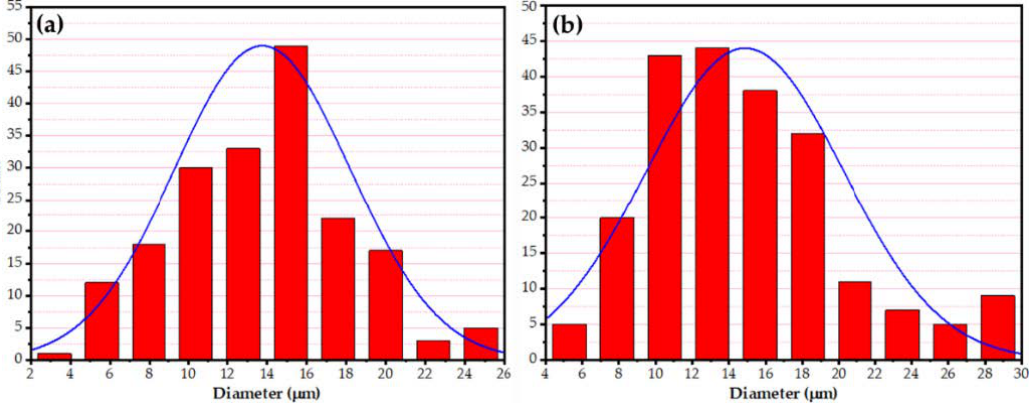
Figure 10. The OM microstructures of the initial material conditions of ( a ) AA2011-T6 and ( b ) AA2011-O.